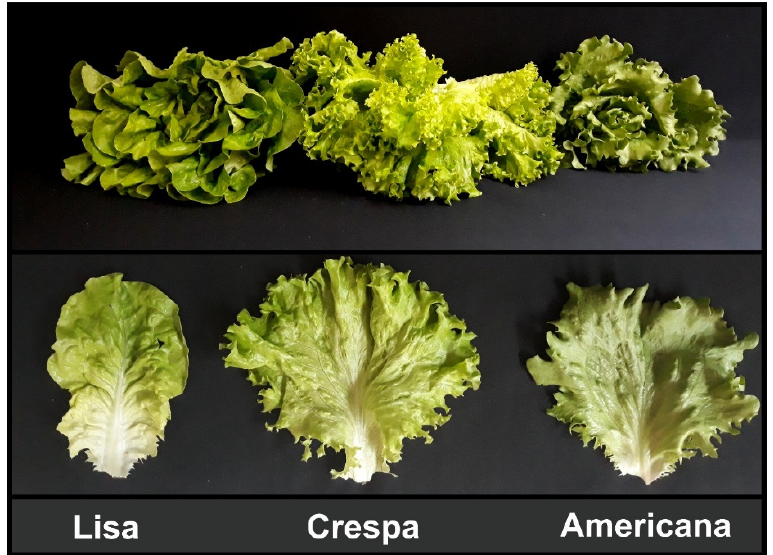
Figure 2. Left to right Lisa, Crespa, and Americana varieties of lettuce; full plants on top, leaves on